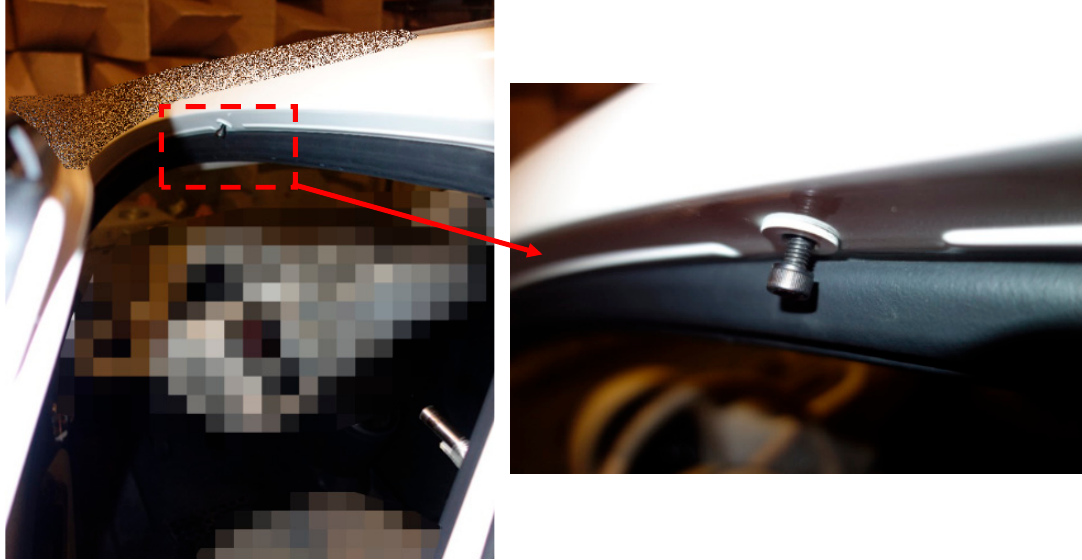
Figure 21. Screw system for generating a gap between the seal and the door frame; general view ( left ); detail ( right ).